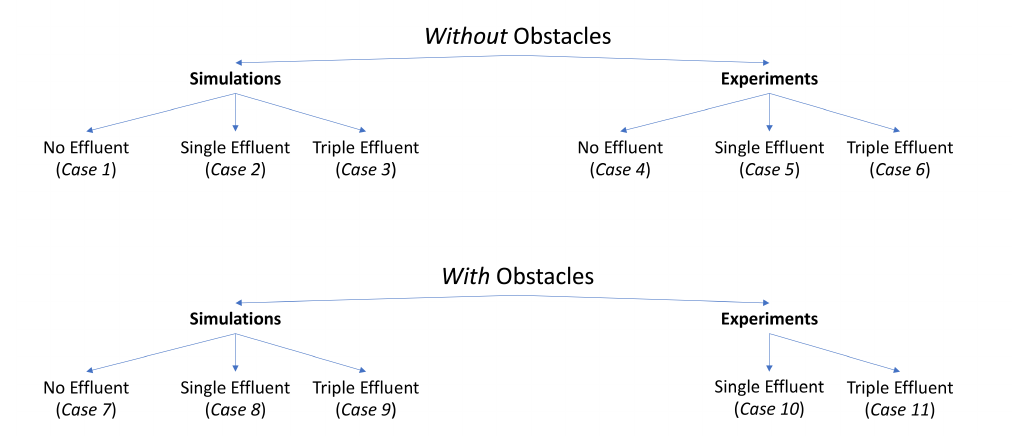
Figure 1. Different scenarios in this work.